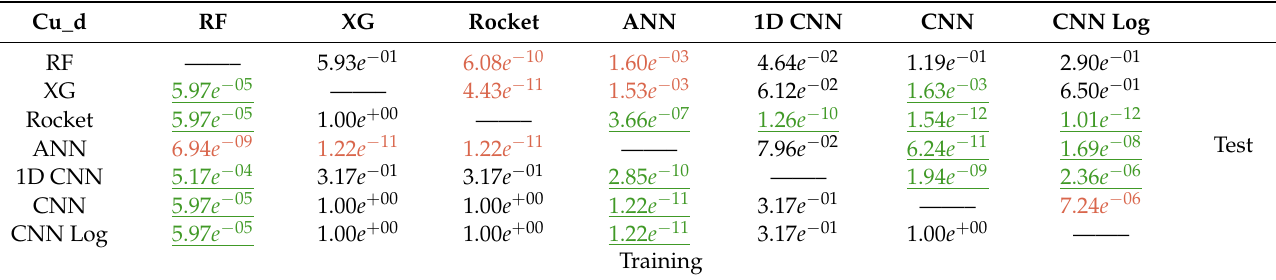
Table A9. Kruskal–Wallis p -values comparing all methods of the Cu_d concentration prediction task. Above the diagonal, we have the results for the test set, and below for the training set. Significant results ( p < 0.01) are represented in green or red when the method on the left is significantly better or worse, respectively.